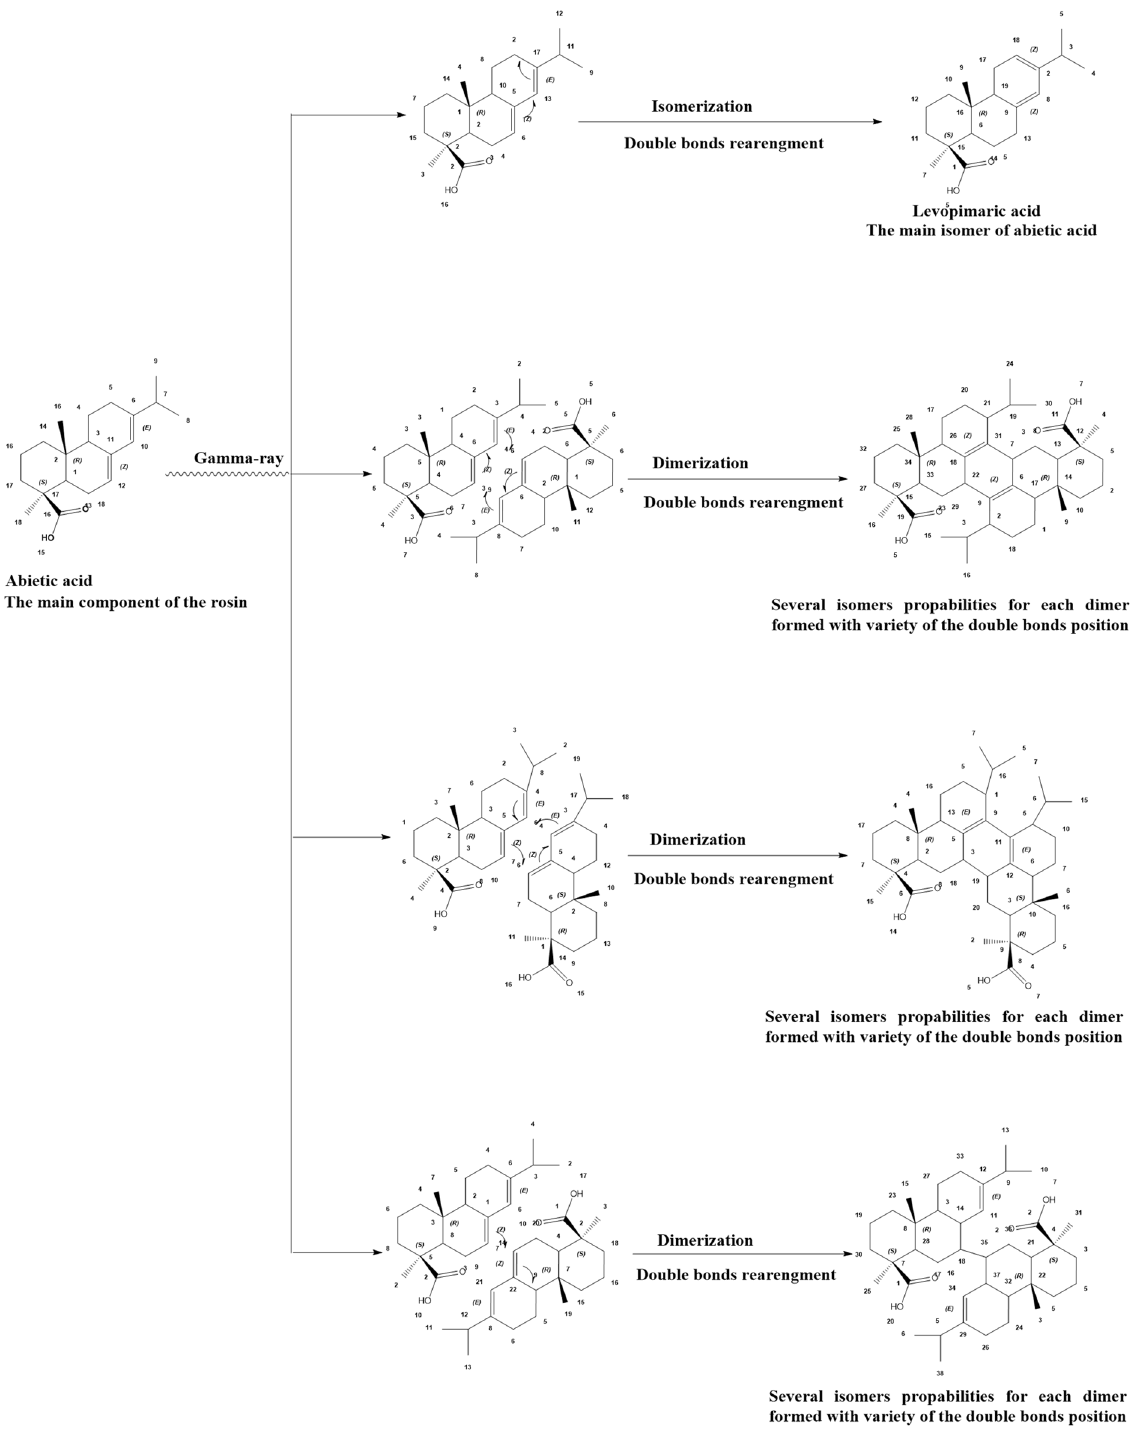
Figure 7. The suggested reaction mechanism of gamma-ray effect on abietic